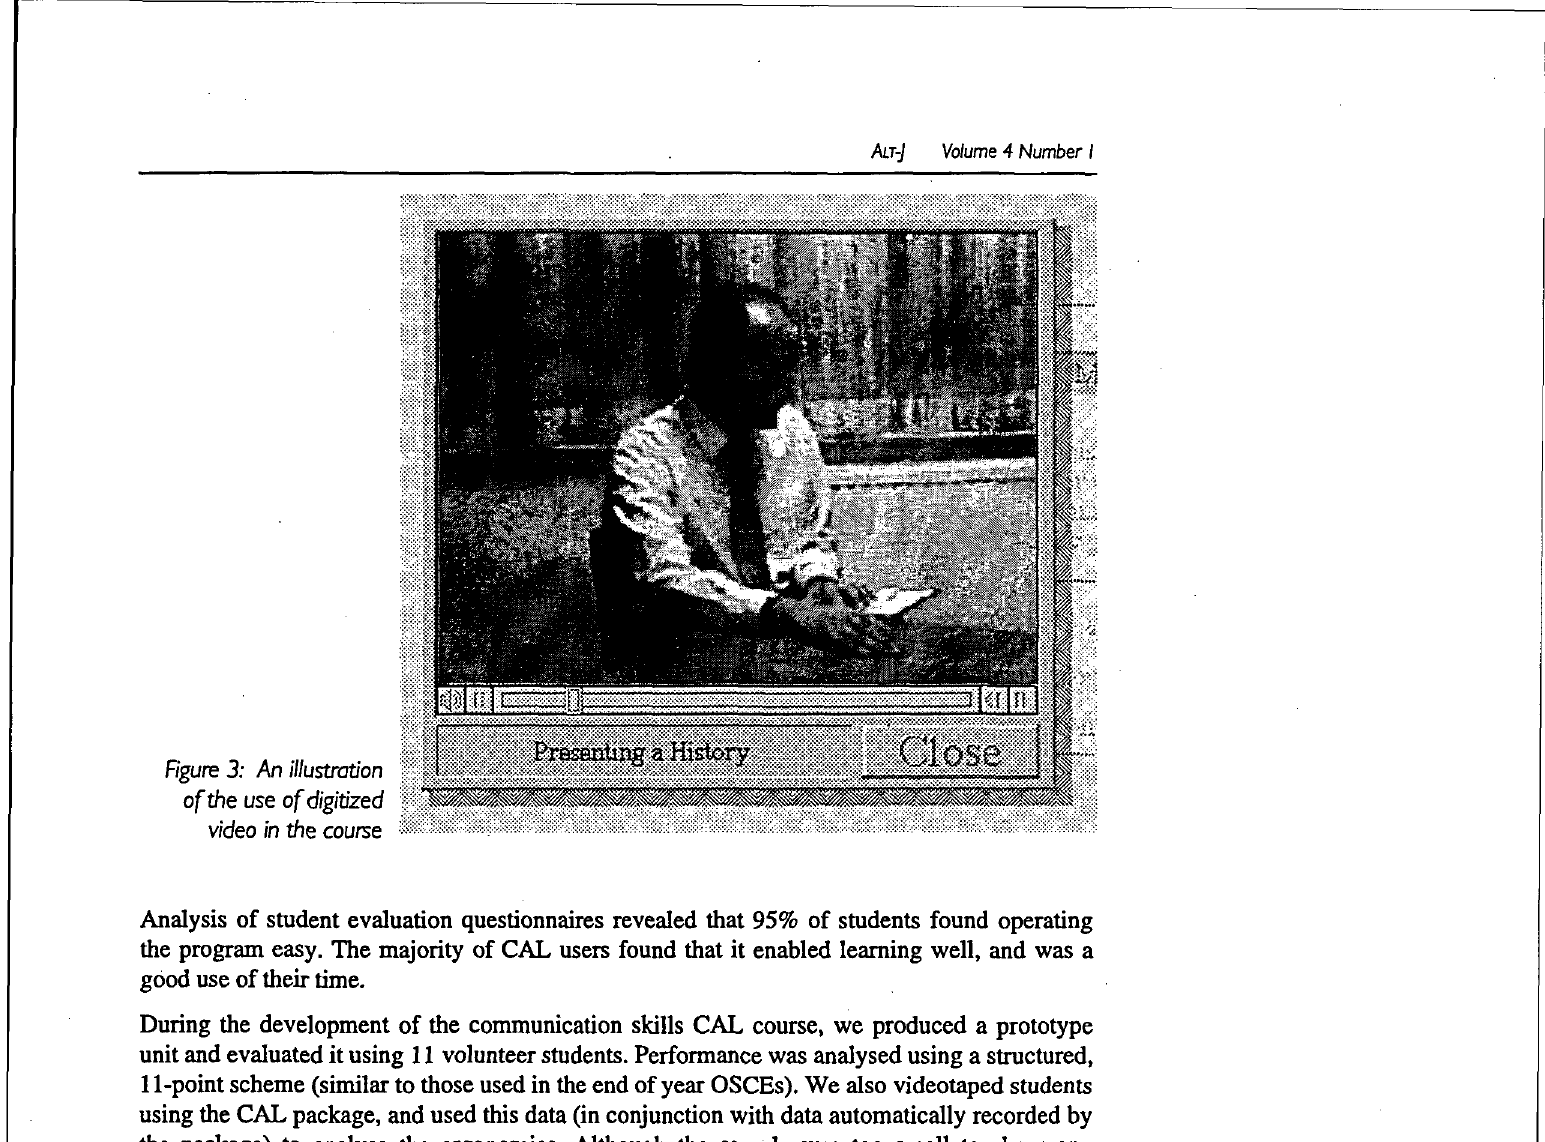
Figure 3: An illustration of the use of digitized video in the